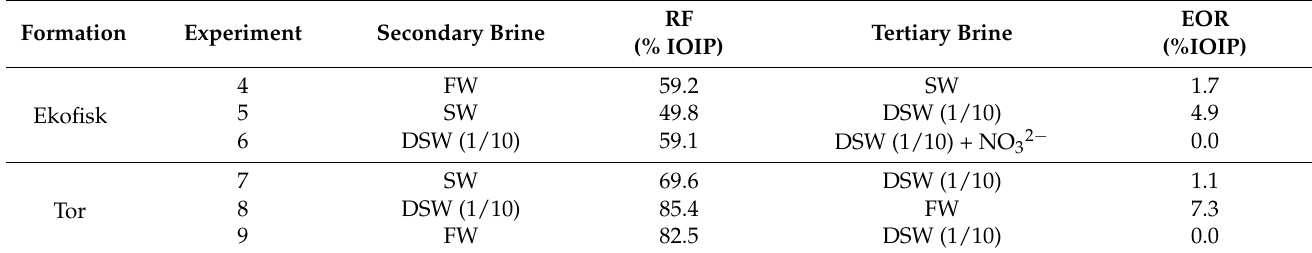
Table 5. Different recovery factors at secondary and tertiary stages for experiments